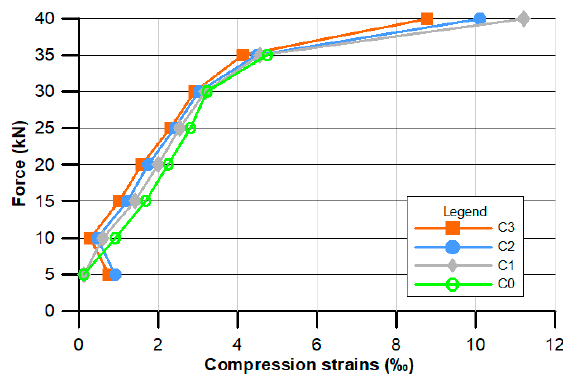
Figure 8. Experimental relationships between concentrated force F and compressive strain 𝜀 .